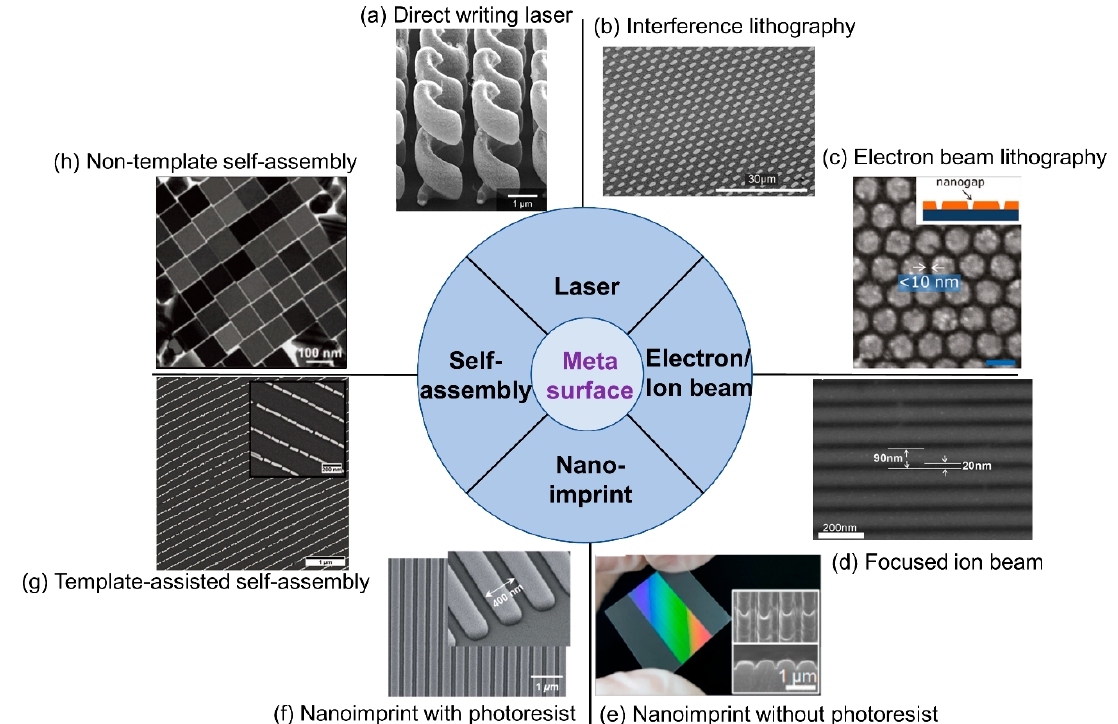
Figure 12. SEM images of meta-surfaces fabricated by various nanofabrication technology ( a ) Cross- sectional view of 3-D helical nanostructures fabricated by direct writing laser, Reprinted with permission from Ref. [148]. Copyright 2009 American Association for the Advancement of Science.; ( b ) A large array of rod shape by interference lithography for surface-enhanced infrared absorption. Reprinted with permission from Ref. [149]. Copyright 2014 WILEY-VCH Verlag GmbH & Co. KGaA, Weinheim. ( c ) An array of gold nanodisk array with sub-10 nm nanogaps produced by electron-beam lithography. Reprinted with permission from Ref. [116]. Copyright 2011 American Chemical Society. ( d ) An array of nanoribbons with 20 nm width produced by focused ion beam. Reprinted with permission from Ref. [126]. Copyright 2022 IOP Publishing. ( e ) A several-centimeter scale of nanopatterns of right 2014 The Royal Society of Chemistry; ( g ) an array of nanoline patterns consisting of serially connected nanorods via dip-coating using wrinkled PDMS substrates as templates. Reprinted with